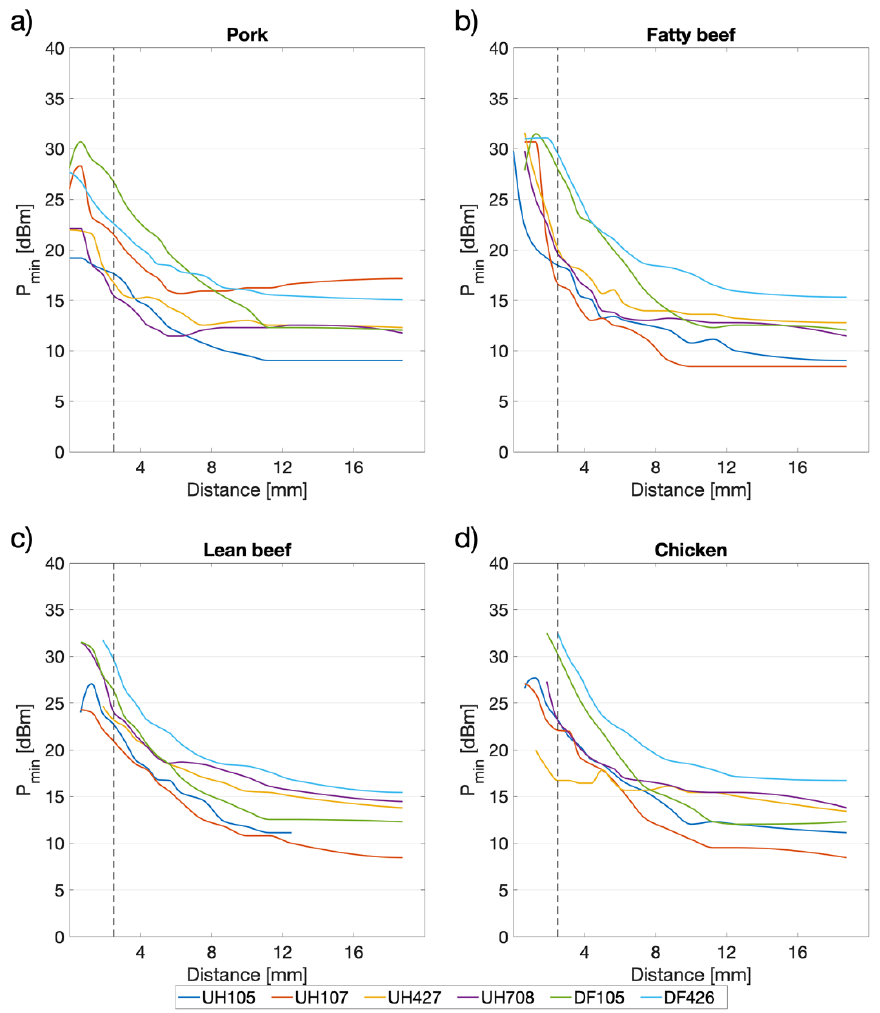
Figure 4. Mean values of the minimum power required to activate the UHF and DF tags ( P min (dBm)) at increasing tag-to-meat distances (mm) when tested on different types of minced meat patties. The dashed lines highlight the minimum distance at which all the six tags were detected. Subfigure ( a ) regards pork, Subfigure ( b ) regards fatty beef, Subfigure ( c ) regards lean beef, while Subfigure ( d ) regards chicken.